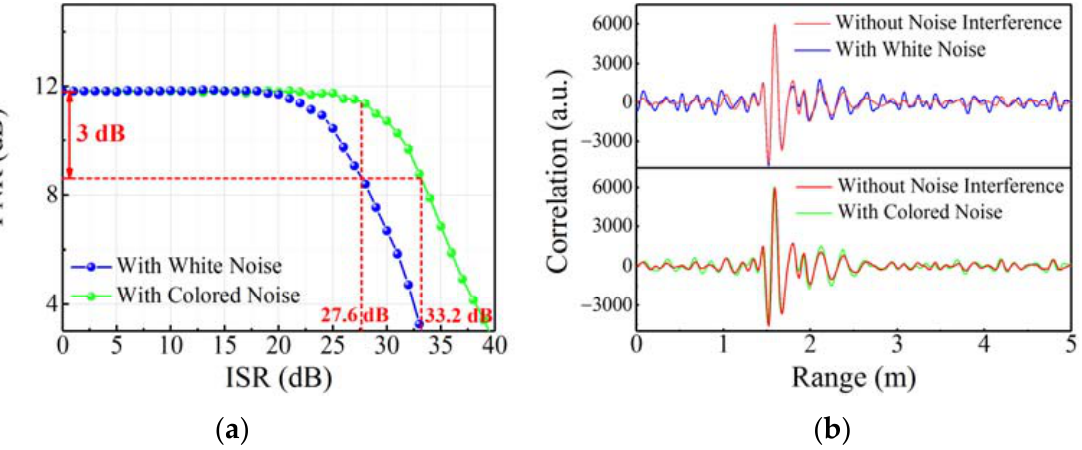
Figure 10. ( a ) Relationship curve between the PNR and ISR; ( b ) comparison results of correlation ranging traces without and with the white/colored noise interference when ISR = 27.6 dB.